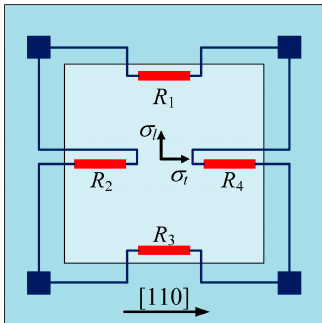
Figure 4. Piezoresistors distributed on the top of diaphragm in a pressure sensor.